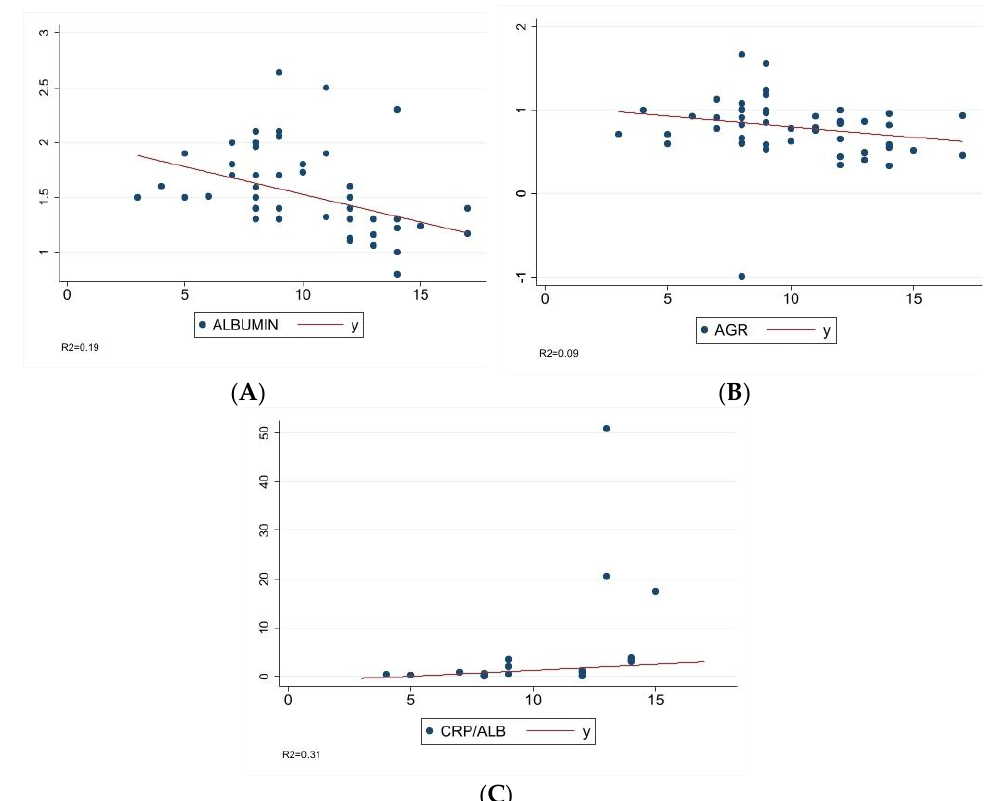
Figure 1. The relationship between the CCECAI score and the serum concentrations of albumin ( A ), AGR ( B ) and CRP/ALB ( C ) before endoscopic procedure (T0) are graphically represented. The sin- gle parameter is on the Y axis, whereas the CCECAI score lies on the X axis. No correlations were found between the median CCECAI score and NLR ( p = 0.5)